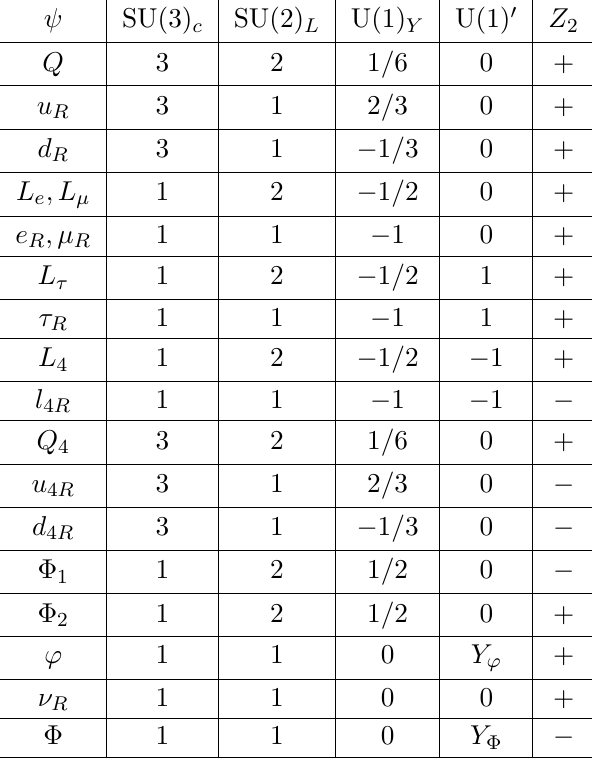
Table 2. Quantum numbers of the particles in the